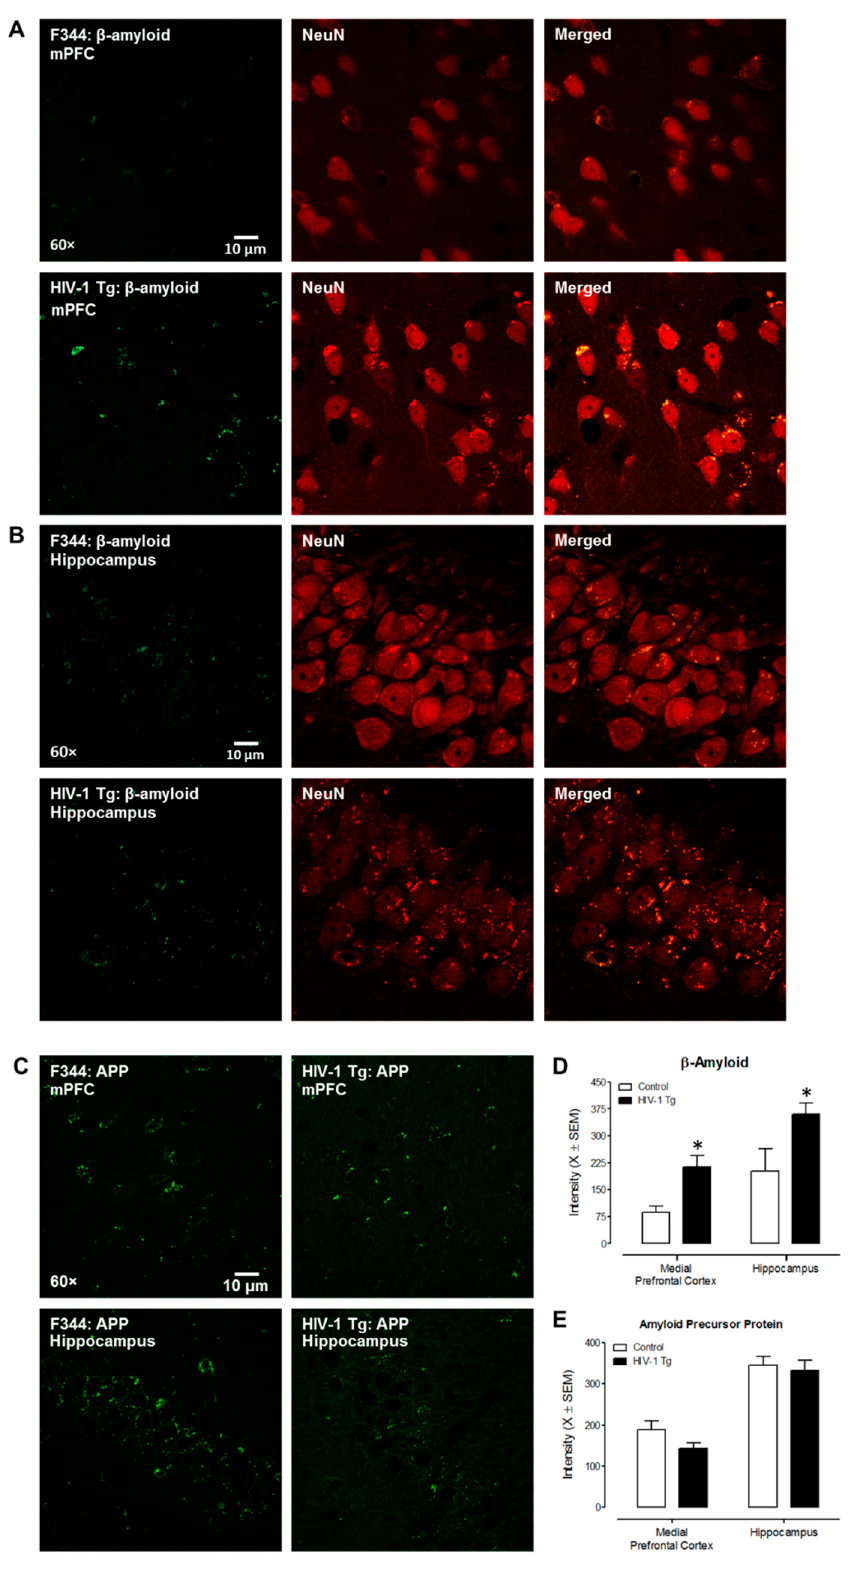
Figure 1. IHC double staining revealed an abnormal intraneuronal accumulation of β -amyloid in the HIV-1 Tg rat. ( A , B ) Representative confocal images of β -amyloid expression and co-localization with NeuN (neuronal marker) in the mPFC and CA3 area of hippocampus in F344/N and HIV-1 Tg rats. The Alexa 488 green fluorescence indicates expression of β -amyloid; the Alexa 594 red fluo- rescence represents NeuN signals. ( C ) Representative images of amyloid precursor protein (APP)